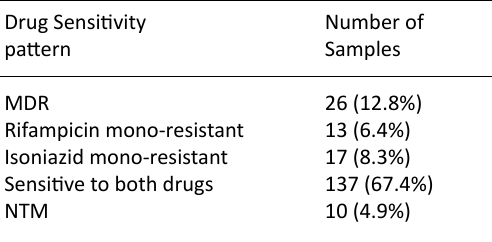
Table 1. Distribution of drug sensitivity pattern in patients Drug Sensitivity